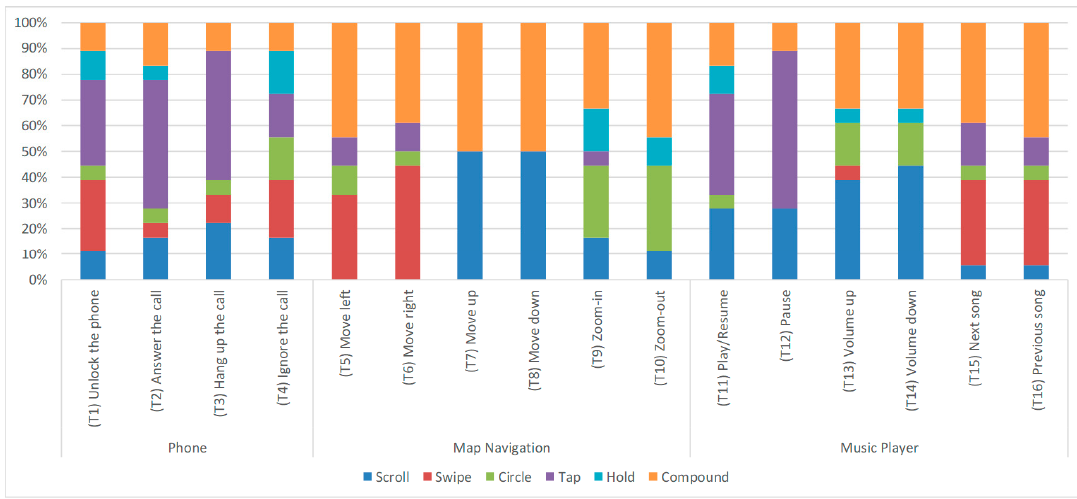
Figure 7. Frequency distribution of actions used for each command in the preferred gesture set. Scrolls were highly preferred for commands move up and down.